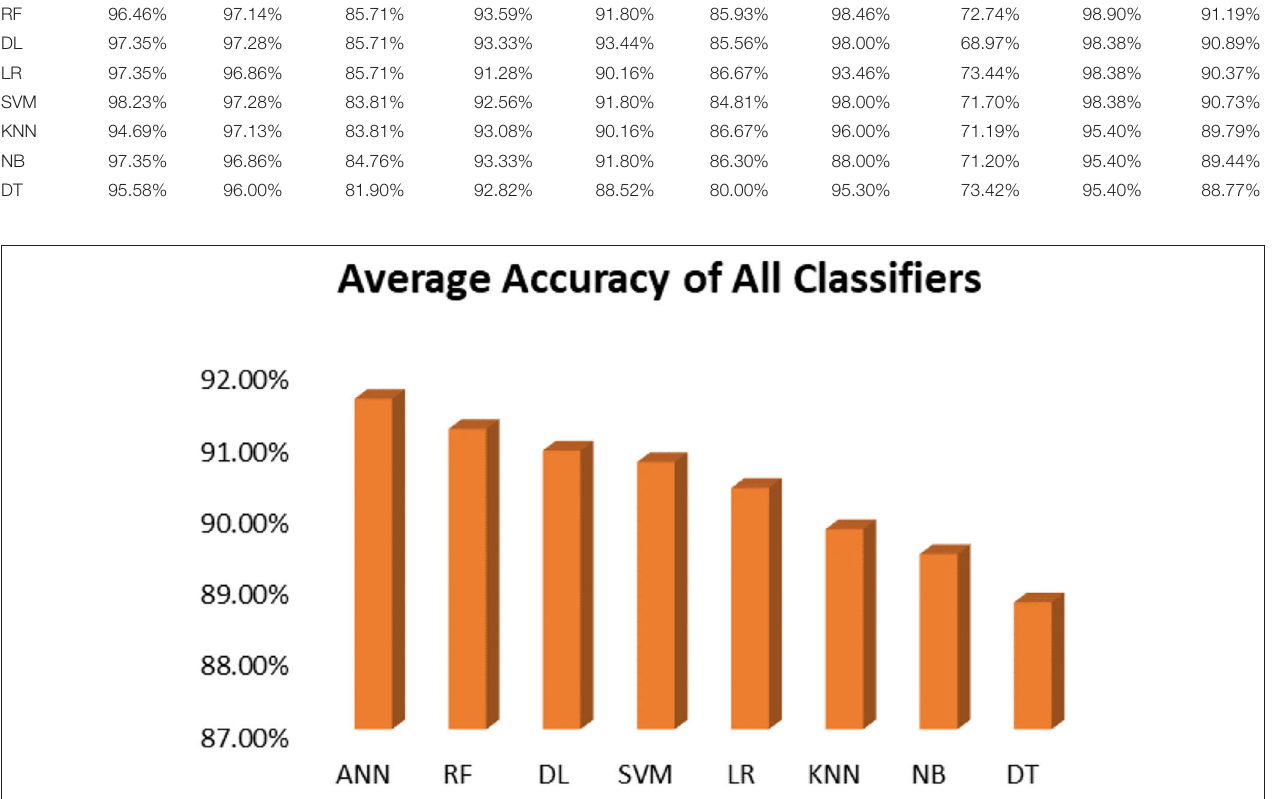
FIGURE 12 | Average accuracy achieved by all classification